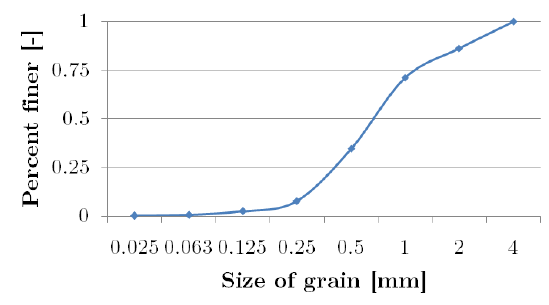
Figure 8. The grain curve of the sand.